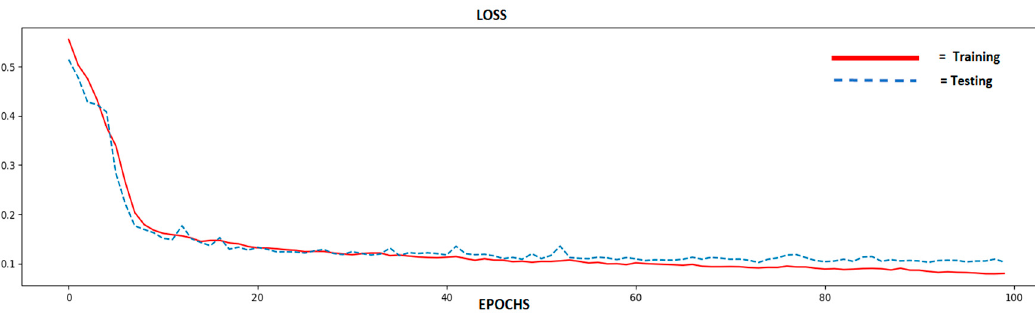
Figure 7. The plot of loss of the LSTM architecture with 90% of training and 10% of the testing set.